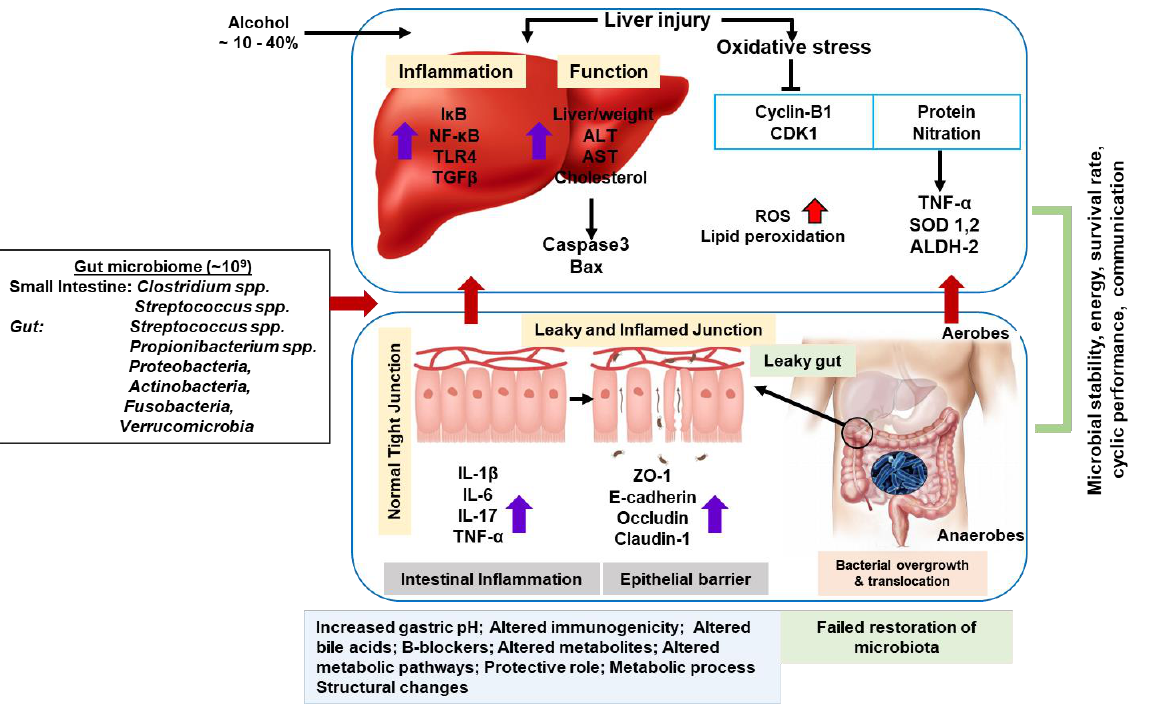
Figure 2. Proposed models for understanding the alcohol-induced liver metabolic damages through gut – liver axis.